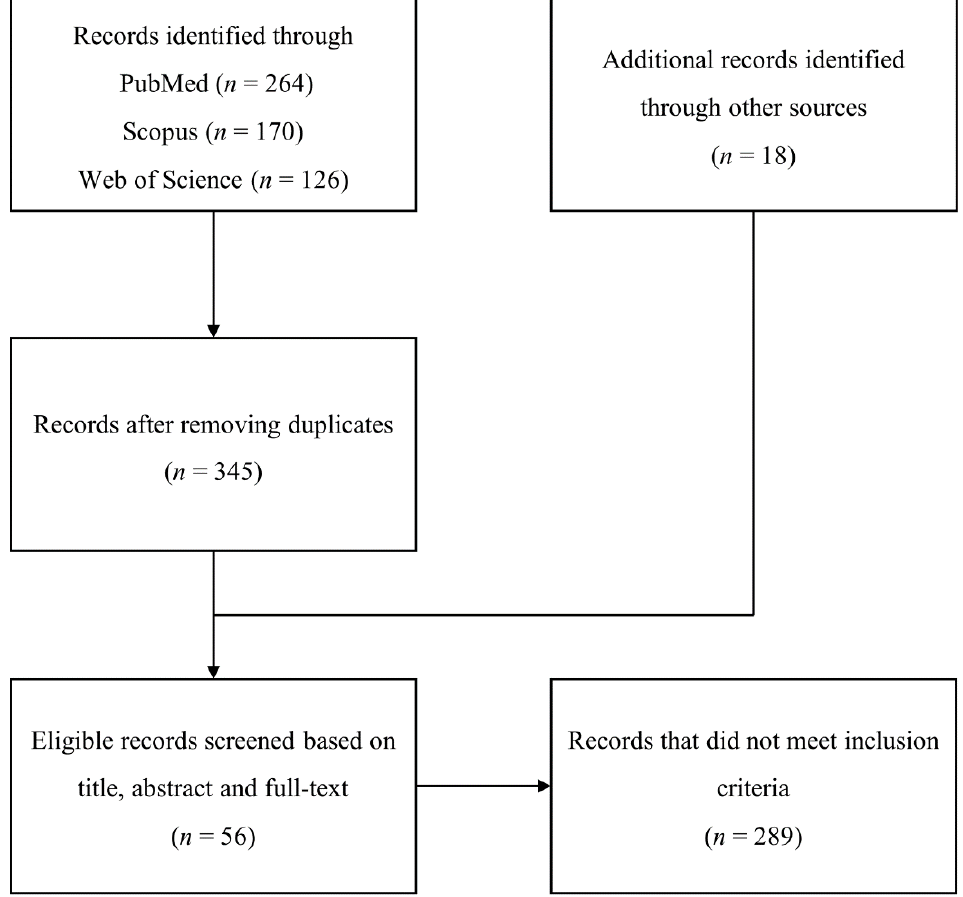
Figure 1. Flow diagram of the literature search procedure for the selection of studies up to 25 October 2020 on the use of plants, mushrooms, algae, decoctions, and their natural products (NPs) in peripheral nerve repair and regeneration. Only articles written in English, and having full-text availability were included. Articles not representing original research studies and NPs derived from sources other than plants, herbs, algae, and mushrooms were excluded.